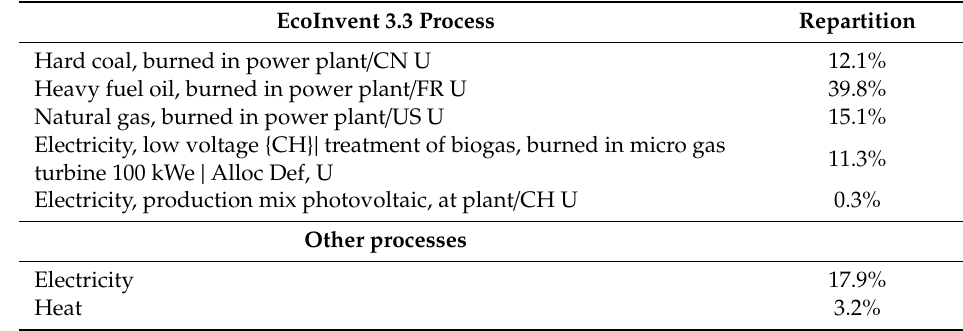
Table A3. 2012 World final consumption modeling with EcoInvent data [70] in accordance with IEA [1] information.